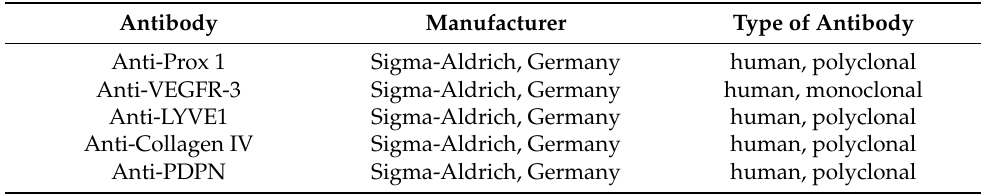
Table 2. Antibodies used in the IHC